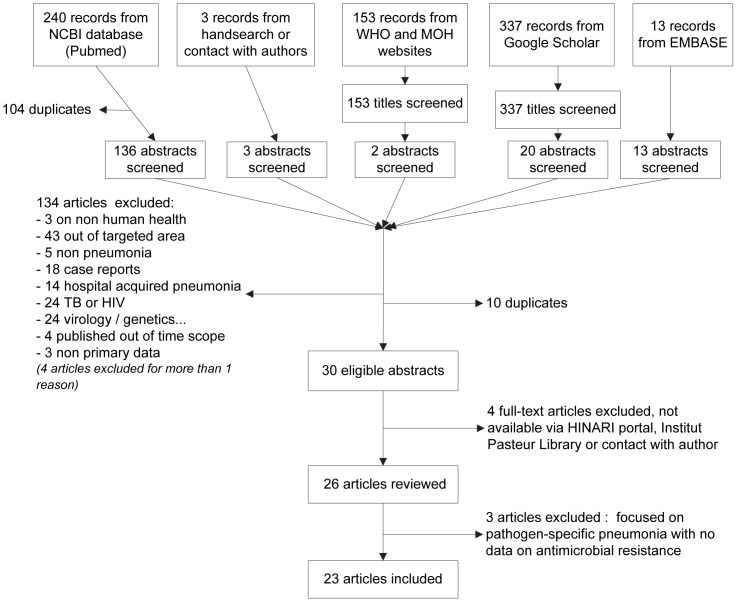
Inclusion flow chart.